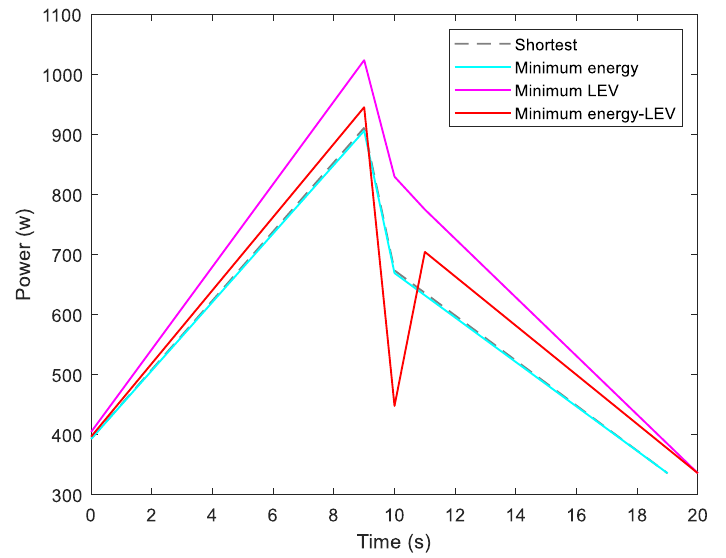
Sensors 2021 , 21 , x FOR PEER REVIEW Figure 17. Comparison of trajectories of the case (3). Figure 17. Comparison of trajectories of the case (3).